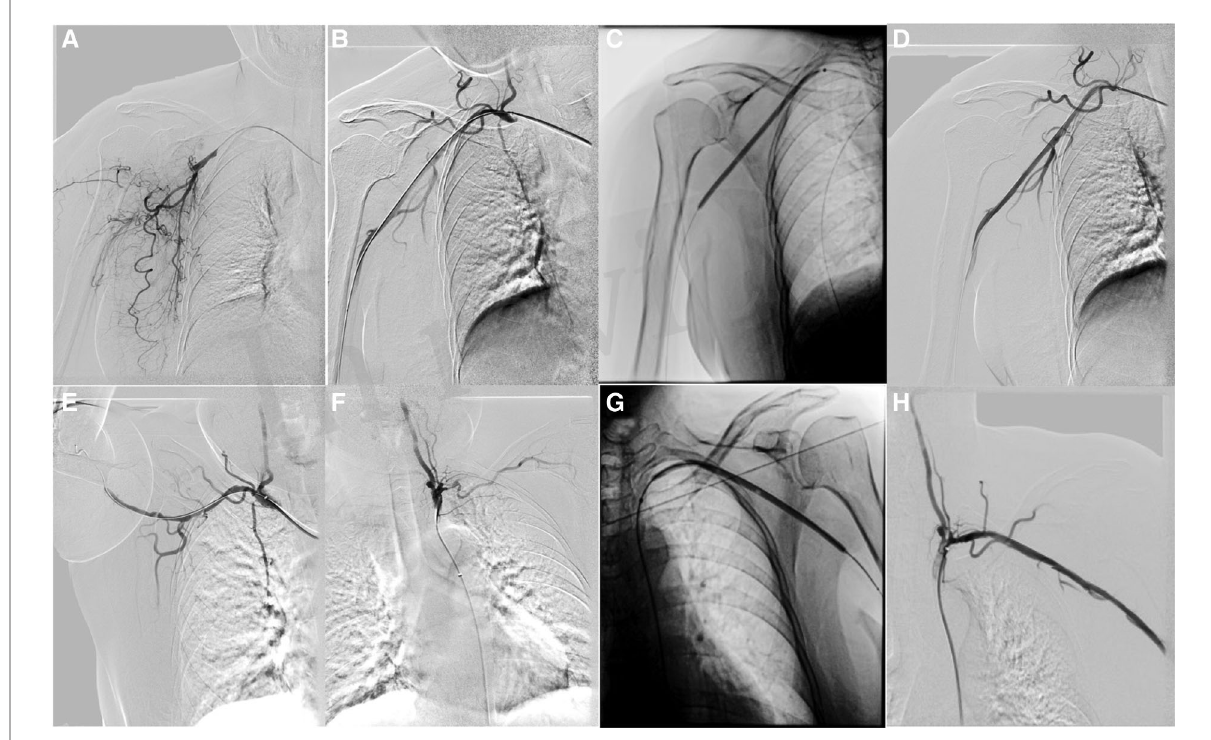
FIGURE 2 Rotarex thrombectomy combined with drug-coated balloon dilation in treating arterial TOS. ( A ) Baseline angiography showing right axillary artery occlusion. ( B ) Angiography after plain old balloon angioplasty in the right axillary artery. ( C ) Drug-coated balloon (DCB) angioplasty in the axillary artery. ( D ) Angiography after DCB angioplasty in the right axillary artery. ( E ) Angiography of the right axillary artery in the excessive abducted and hyperextension position. ( F ) Baseline angiography showing left subclavian and axillary artery occlusion. ( G ) Angiography after DCB angioplasty in the left subclavian and axillary artery. ( H ) Angiography after DCB angioplasty in the left subclavian and axillary